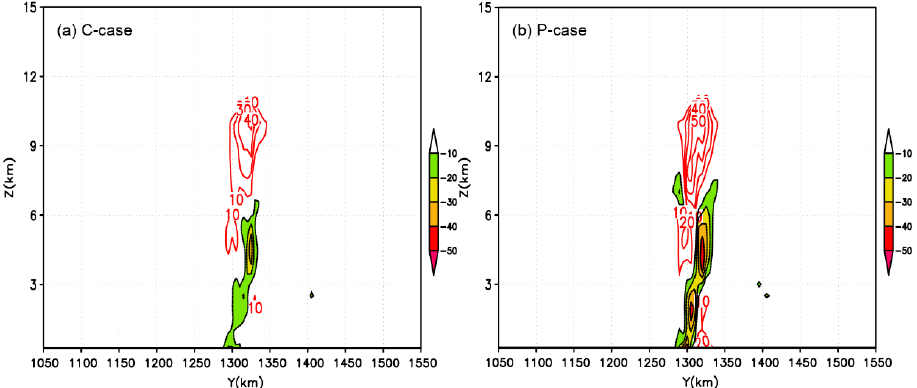
Figure 12. Vertical cross sections of zonal-mean Divergence at t = 21 h (The contours show divergence greater than 10 − 5 s − 1 , the color shadings show convergence less than 10 − 5 s − 1 ). Only a 500 km × 15 km of the domain is presented. The left panel shows C-case, the right panel shows P-case.